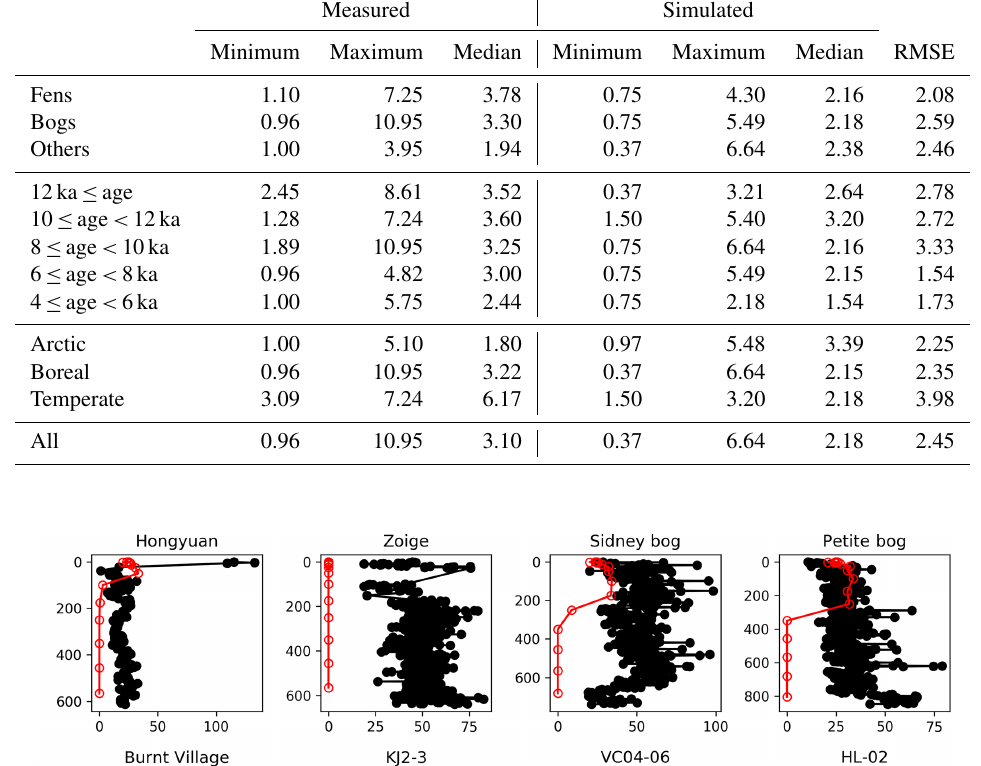
Table 2. Measured and simulated minimum, maximum, and median depth (m) of peat cores, grouped by peatland types, ages, and climatic regions. The root-mean-square errors between observations and simulations are also listed.